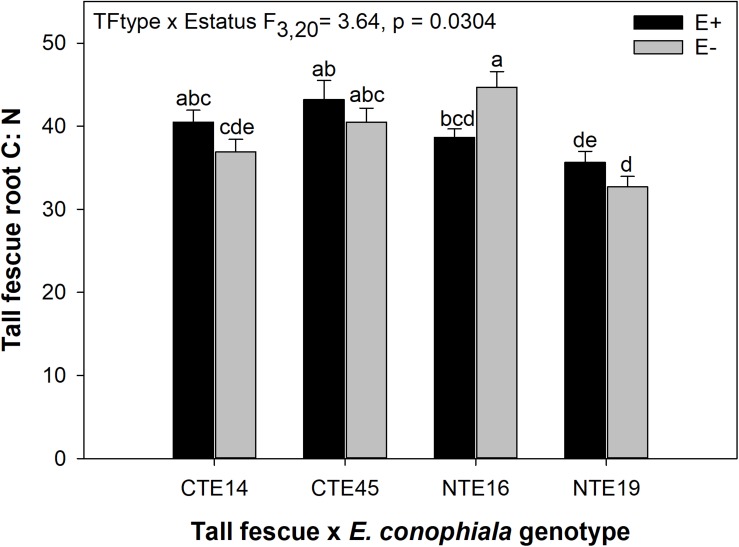
Interactive effects of tall fescue symbiotic genotype and endophyte status on the ratio of C:N in belowground tall fescue root tissue. Bars indicate means ± 1 S.E. Bars sharing no common letter (a,b,c,d,e) indicate significant differences between means (α = 0.05).